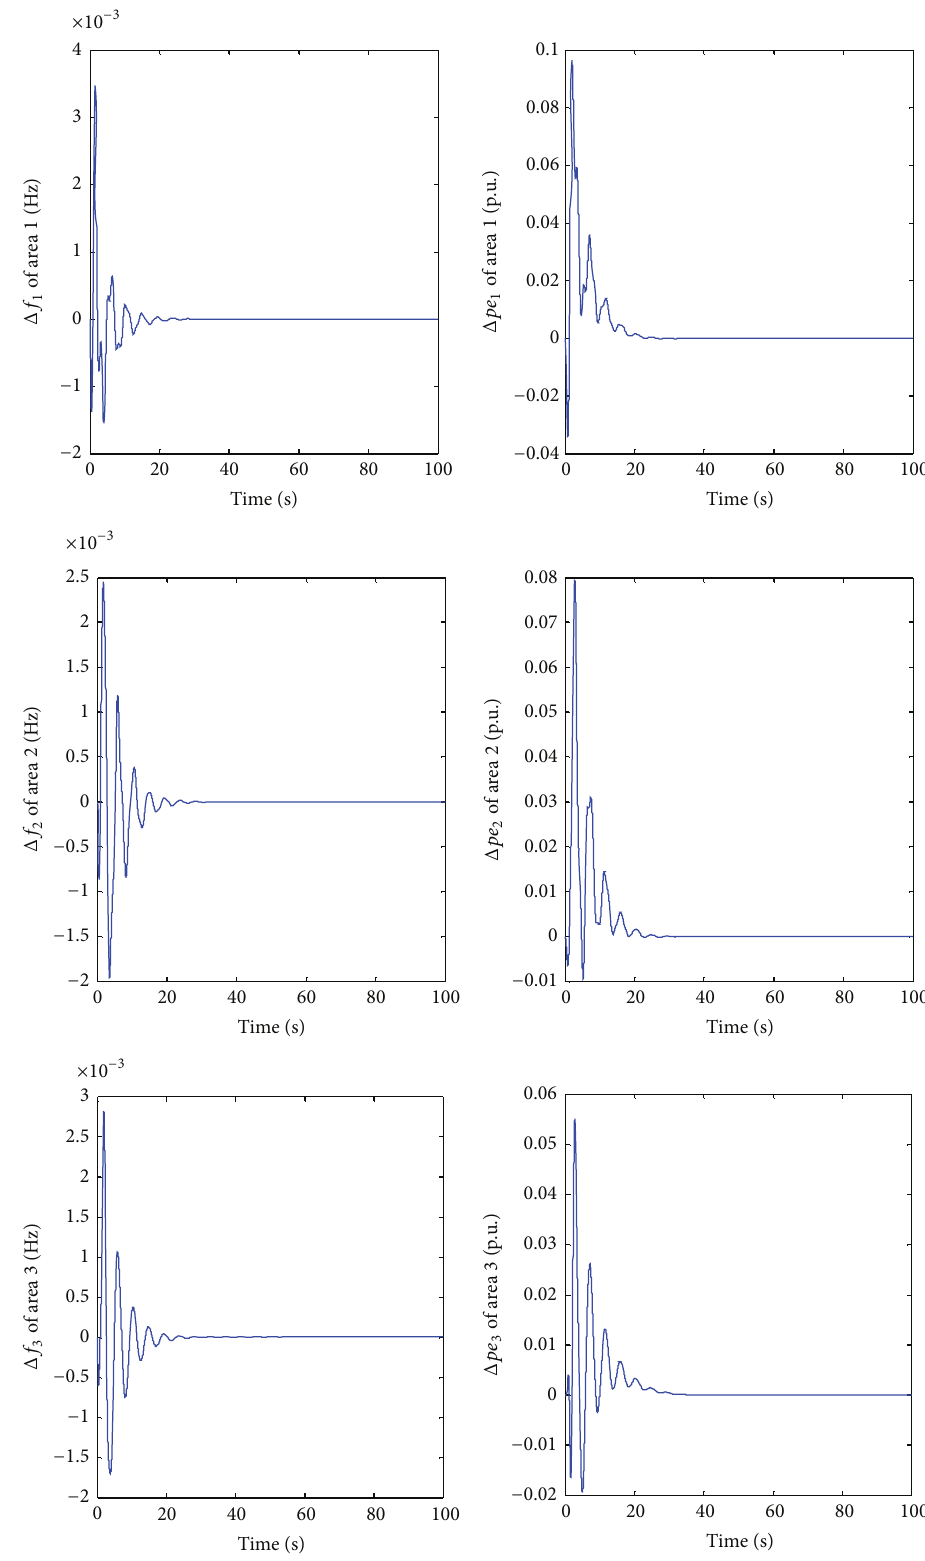
Figure 7: Step responses of the expanded system when 𝐸 1,3 varies from 1 to